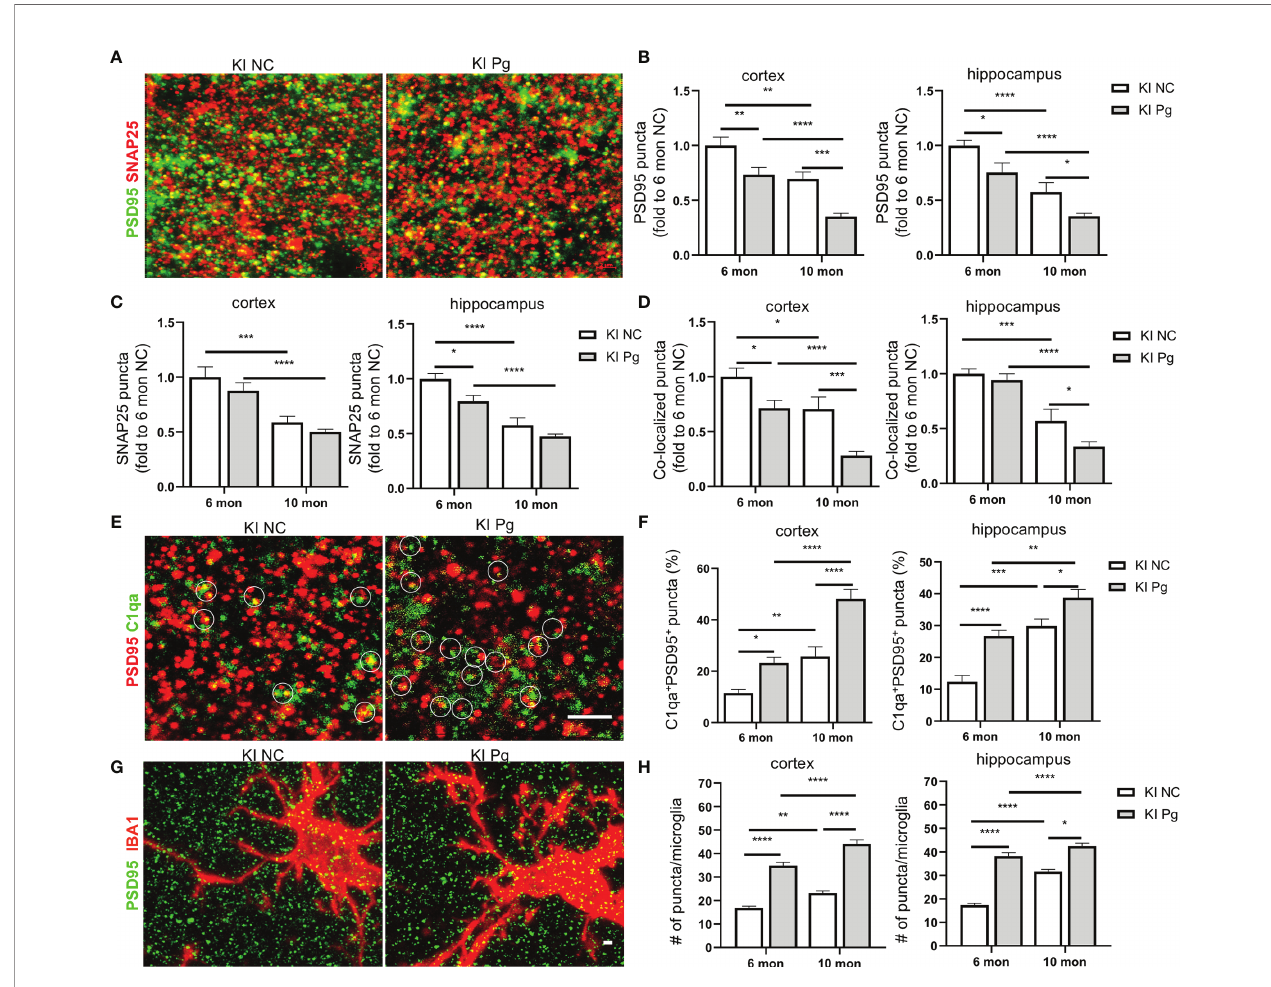
FIGURE 7 | Pg infection enhances microglial elimination of synapses in App KI mice. (A) Representative high magni fi cation Z-stack images showing SNAP 25 (presynaptic marker, red) and PSD95 (postsynaptic marker, green) synaptic terminals in the cortex and hippocampus from non-infected and Pg-infected App KI mice at 10 months of age. (B – D) Quanti fi cation of PSD95 puncta (B) , SNAP25 puncta (C) , and the co-localized PSD95 and SNAP25 puncta (D) in the cortex and hippocampus CA1 regions from non-infected and Pg-infected App KI mice at 6 and 10 months of age. Scale bar: 2 µm. (E) Representative high magni fi cation Z- stack images of C1qa (green) and PSD95 (red) co-stained puncta in the cortex and hippocampus of the brains from non-infected and Pg-infected App KI mice at 10 months of age. Circles show examples of C1qa puncta co-localized with PSD95 puncta. Scale bar: 4 µm. (F) Quanti fi cation of co-stained C1qa and PSD95 in the cortex and hippocampus CA1 regions from non-infected and Pg-infected App KI mice at 6 and 10 months of age. (G) Representative high magni fi cation Z-stack images of subicular microglia (IBA1 + , red) co-stained with PSD95 (green) from non-infected and Pg-infected App KI mice at the 10 months of age, displaying elimination of synapses by microglia. Scale bar, 5 µm. (H) Quanti fi cation of engulfed PSD95 puncta density in microglia in the cortex and hippocampus CA1 regions of the brains from non-infected and Pg-infected App KI mice at 6 and 10 months of age. Data are expressed as mean ± SEM (n=4-7 mice/group). * P < 0.05, ** P < 0.01, *** P < 0.001, **** P < 0.0001 by two-way ANOVA followed with Tukey